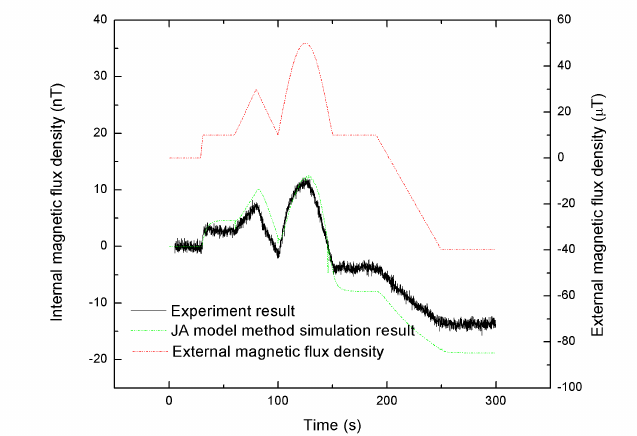
Figure 6. The wave of the MSR at HIT when the external field is arbitrary.